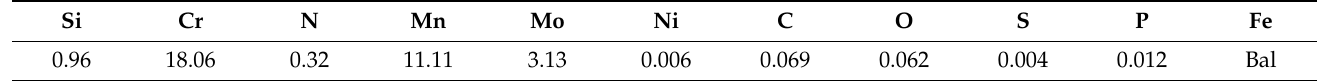
Figure 1. Microstructure of high-nitrogen stainless steel: ( a ) 100µm resolution; ( b ) 10µm resolution. Table 1. Chemical composition of nitrogen-containing stainless steel (wt.%).